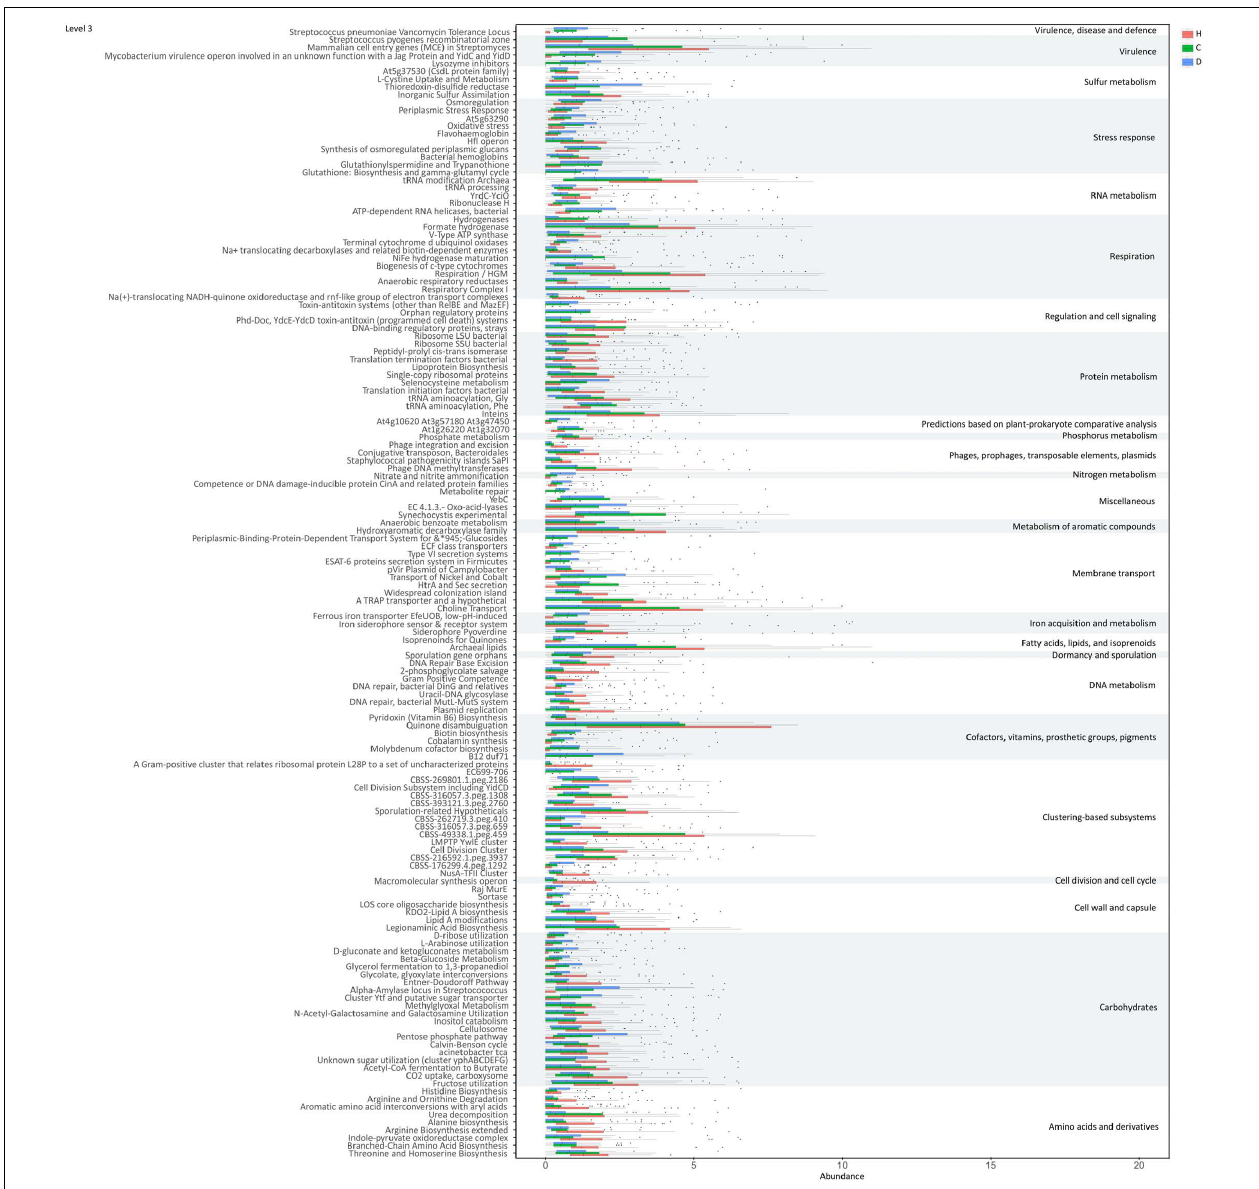
FIGURE 5 | Functions varied during liver cirrhosis progression at level